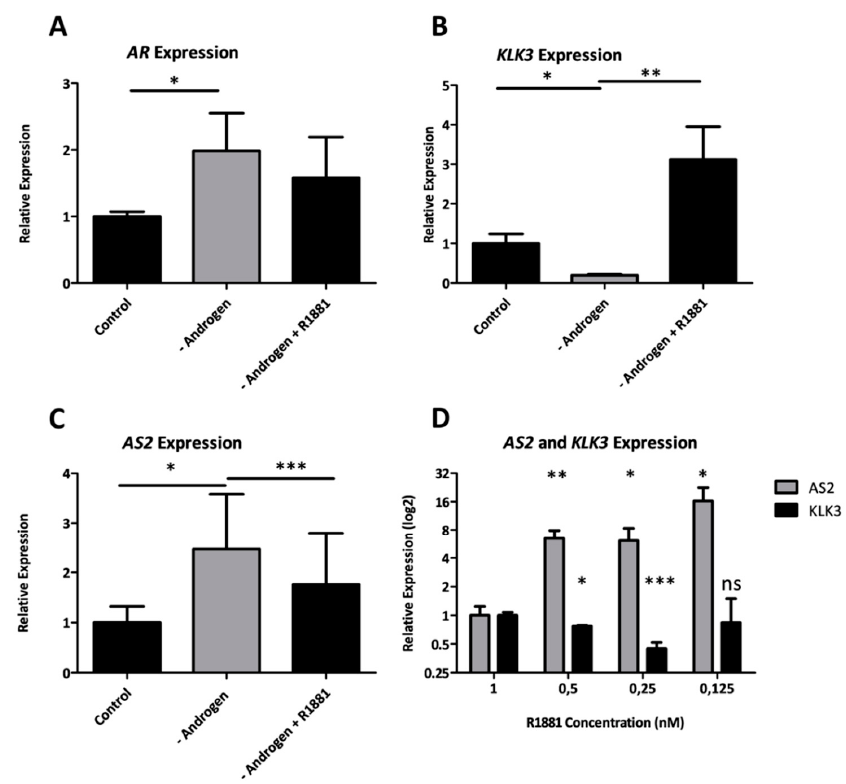
Figure 4. The expression of KLK3 , AR , and AS2 measured via qPCR in LNCaP cells cultured with fetal bovine serum (Control), charcoal stripped serum (CSS) (-Androgen) or CSS with synthetic androgen R1881 (-Androgen + R1881) ( A – C ). AS2 and KLK3 expression measured via qPCR in LAPC-4 cells cultured in decreasing concentrations of R1881 ( D ). Pairwise means comparison was done using a T -test, *: p < 0.05, **: p < 0.01, ***: p < 0.001.